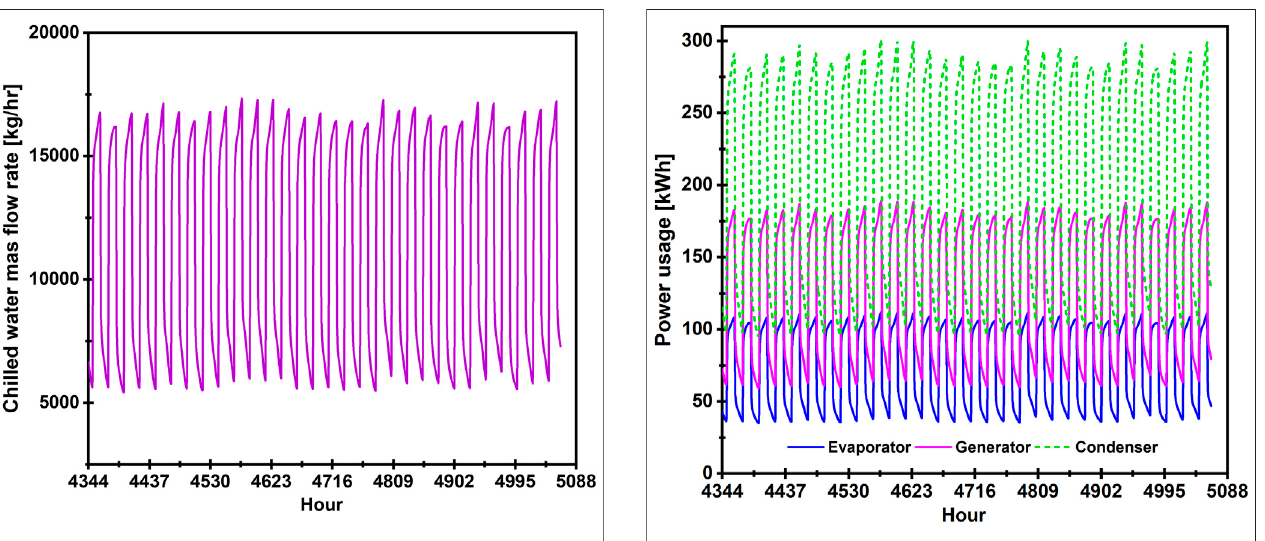
FIGURE 9 | The variations in power usage in evaporator, generator and condenser units.